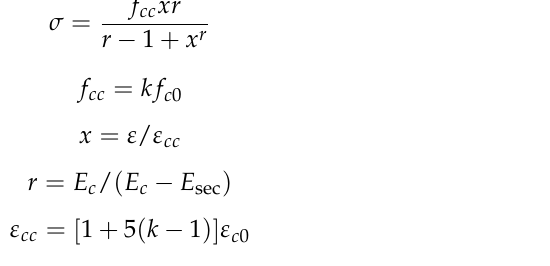
Table 5. Comparing the simulation data with the test